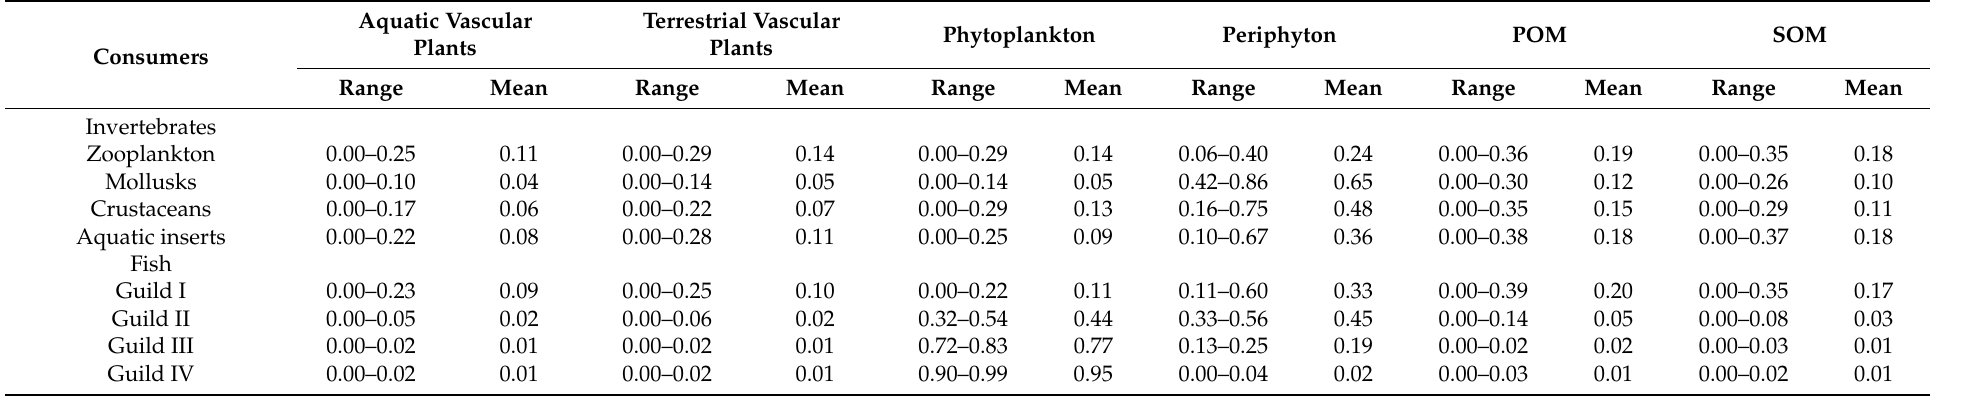
Table 4. Contributions (95% Bayesian credible interval) of basal resources to consumers in the midstream of the Chishui